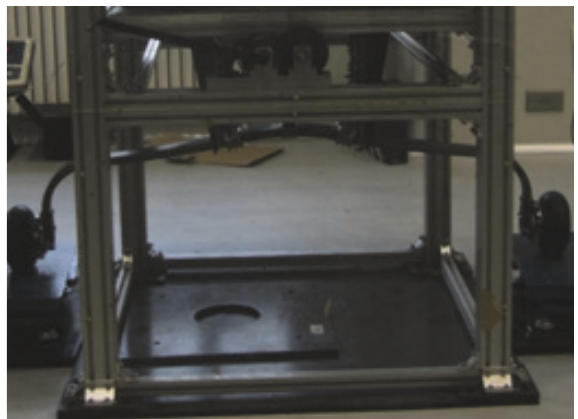
Figure 10: System of drop